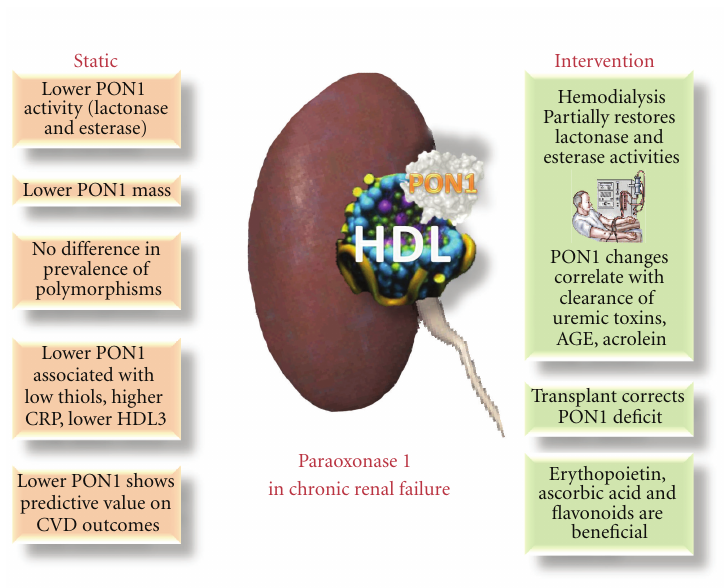
Figure 1: Paraoxonase 1 activity and function are compromised in chronic renal failure patients. This diagram summarizes the main findings discussed in the text as reported during the past decade in the